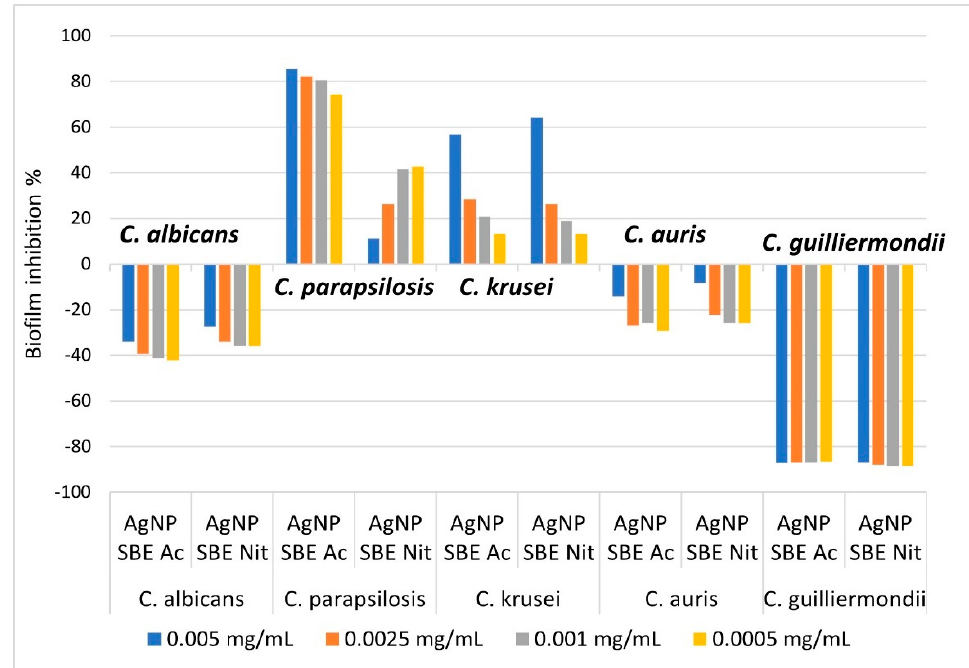
Figure 3. The influence of AgNP SBEs on Candida spp. biofilm production (%). 2.6. The Influence of the AgNP SBEs on the Germ Tubes Production of C. albicans The MICs of AgNP SBE Ac significantly inhibited the production of germ tubes of C. albicans ( p = 0.0001 compared to both control and AgNP SBE Nit). The production of germ tubes was not influenced by MICs of AgNP SBE Nit ( p = 1, compared to control) (Figure 4).